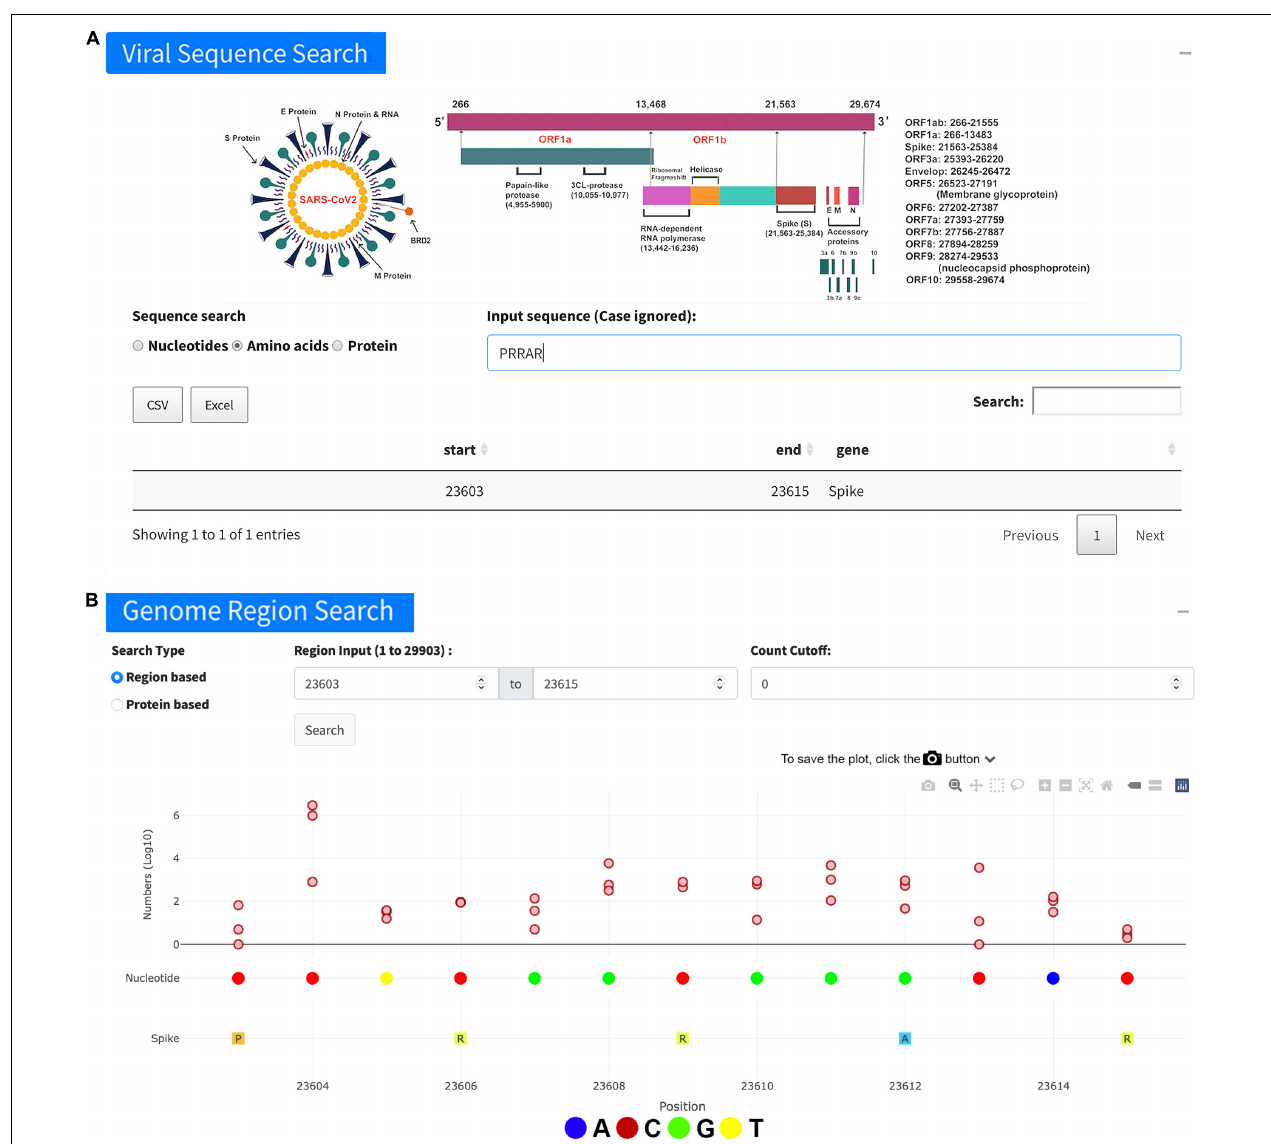
FIGURE 2 | Overview of viral sequence search. (A) An example of searching the furin cleavage site “PRRAR” using the “Viral Sequence Search.” The table lists the search results including start and end positions of the sequence. (B) More detailed information about the viral genome positions 23,603–23,615 for the sequence “PRRAR” achieved on the page of “Genome region search” after the outcome in the table (A) was